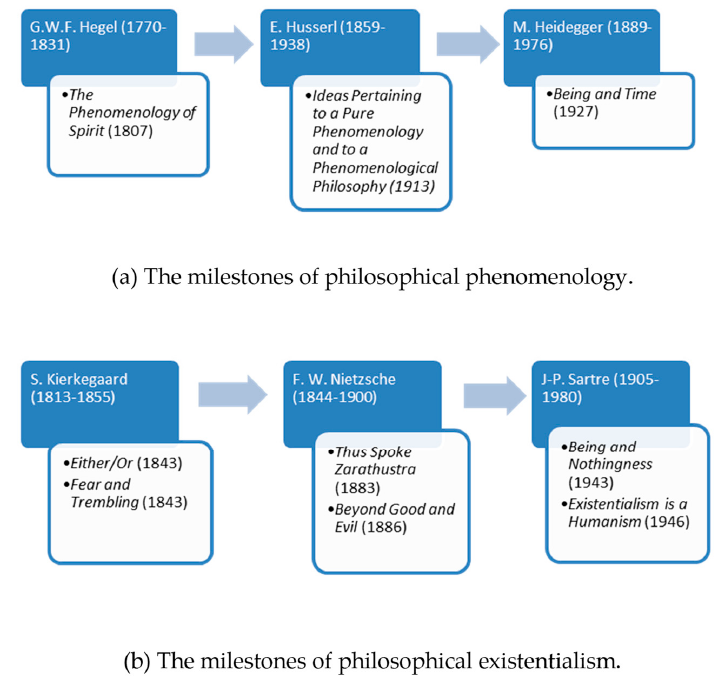
Figure 2. The milestones of philosophical phenomenology and philosophical existentialism. ( a ) The milestones of philo- sophical phenomenology. ( b ) The milestones of philosophical